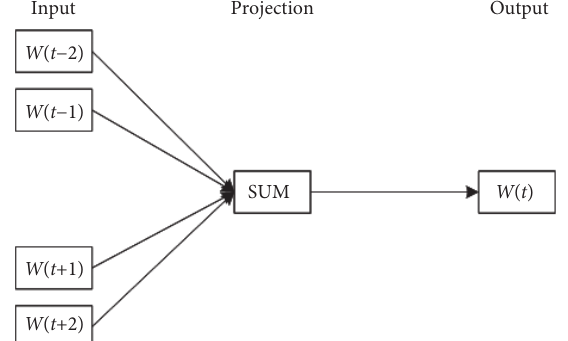
Fig. 1 Structure diagram of the CBOW model. W(t) is the target word and